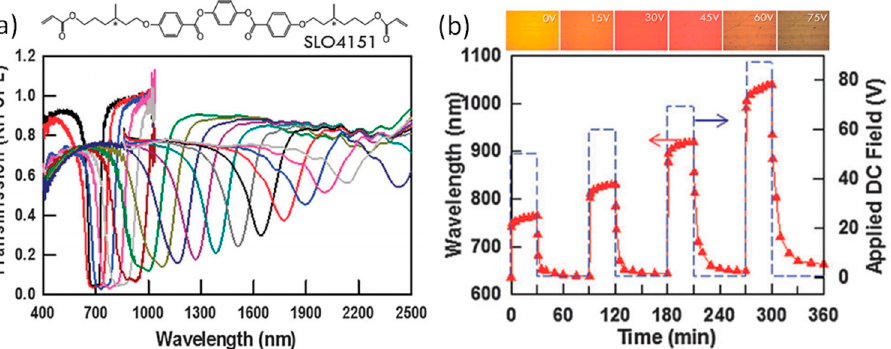
Figure 2. ( a ) Transmission spectra of a PSCLC formulated with 1 wt.% Irgacure 369 and a chiral liquid crystal monomer (SL04151, inset) and cured at 80–100 mW cm − 2 for 3 min with increasing voltage from 0 V to 160 V. ( b ) Variation in reflection wavelength of a PSCLC with 5 wt.% polymer concentration in an experiment in which DC voltages of 50 V, 60 V, 69 V, and 87 V. The voltages were directly applied to the cells and continuously applied for 30 min. POM images in reflection images increasing DC voltages from 0 V to 75 V. The red triangle indicates the notch position of PSCLC and the blue dashed line represents the applied DC field. Cells with a thickness of 15 µ m were used. Adapted from ref.